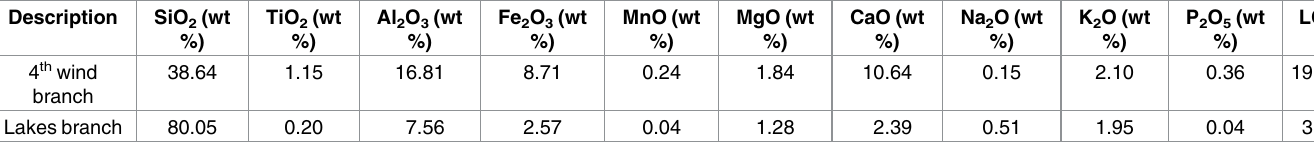
Table 2. Chemical composition (XRF) of the predominant cave